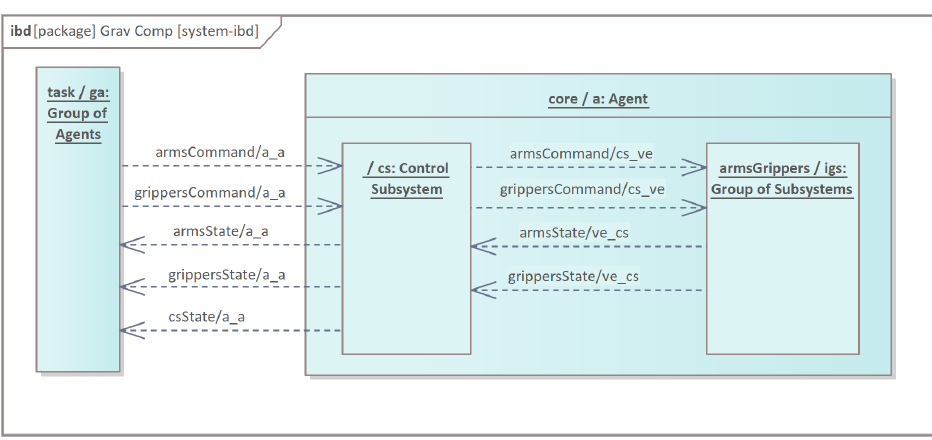
Figure 2. System general structure.